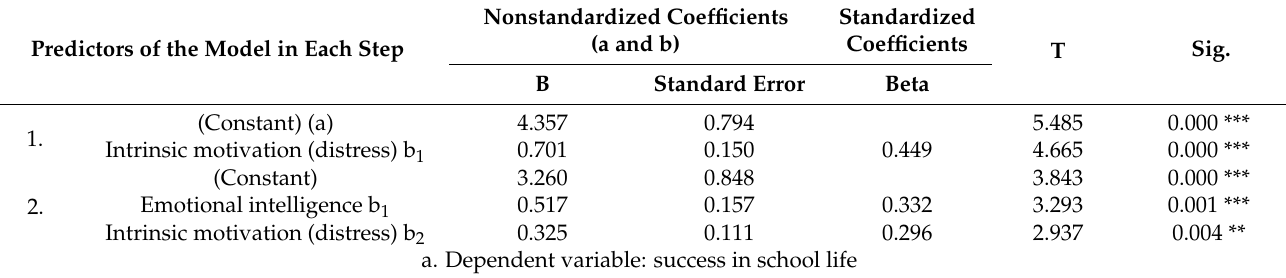
Table 4. Values of the constant (a) and of the coefficients (b) in the inferred multiple regression equation. Source: own